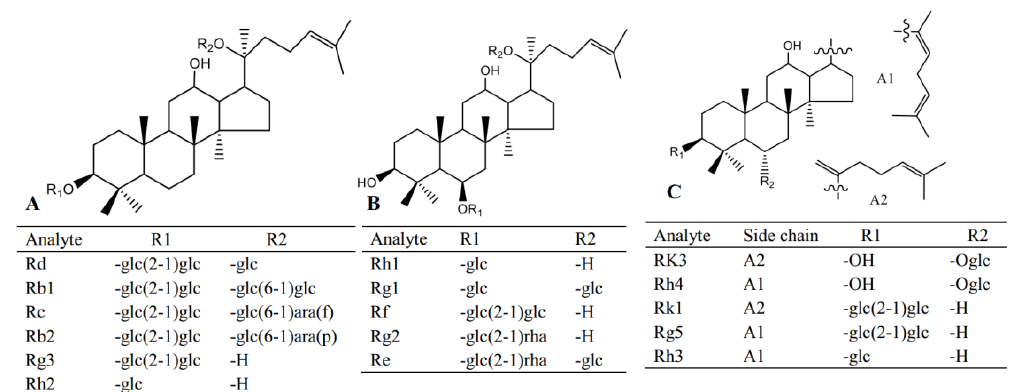
Figure 5. The structures of the analytes in this study.